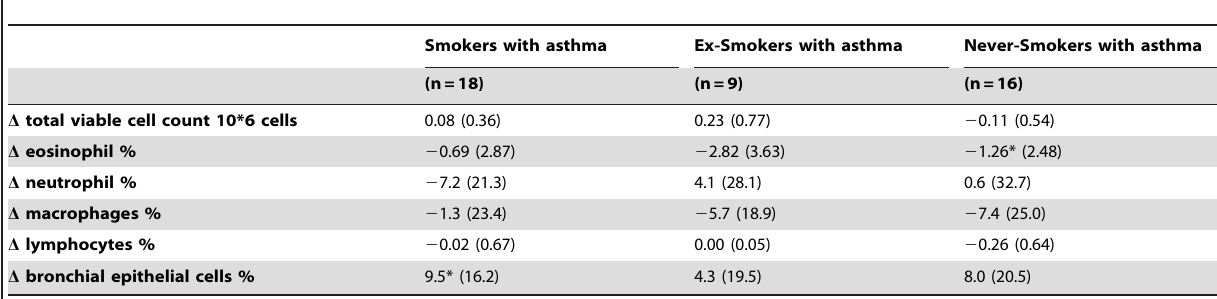
Table 2. Sputum profiles changes in response to